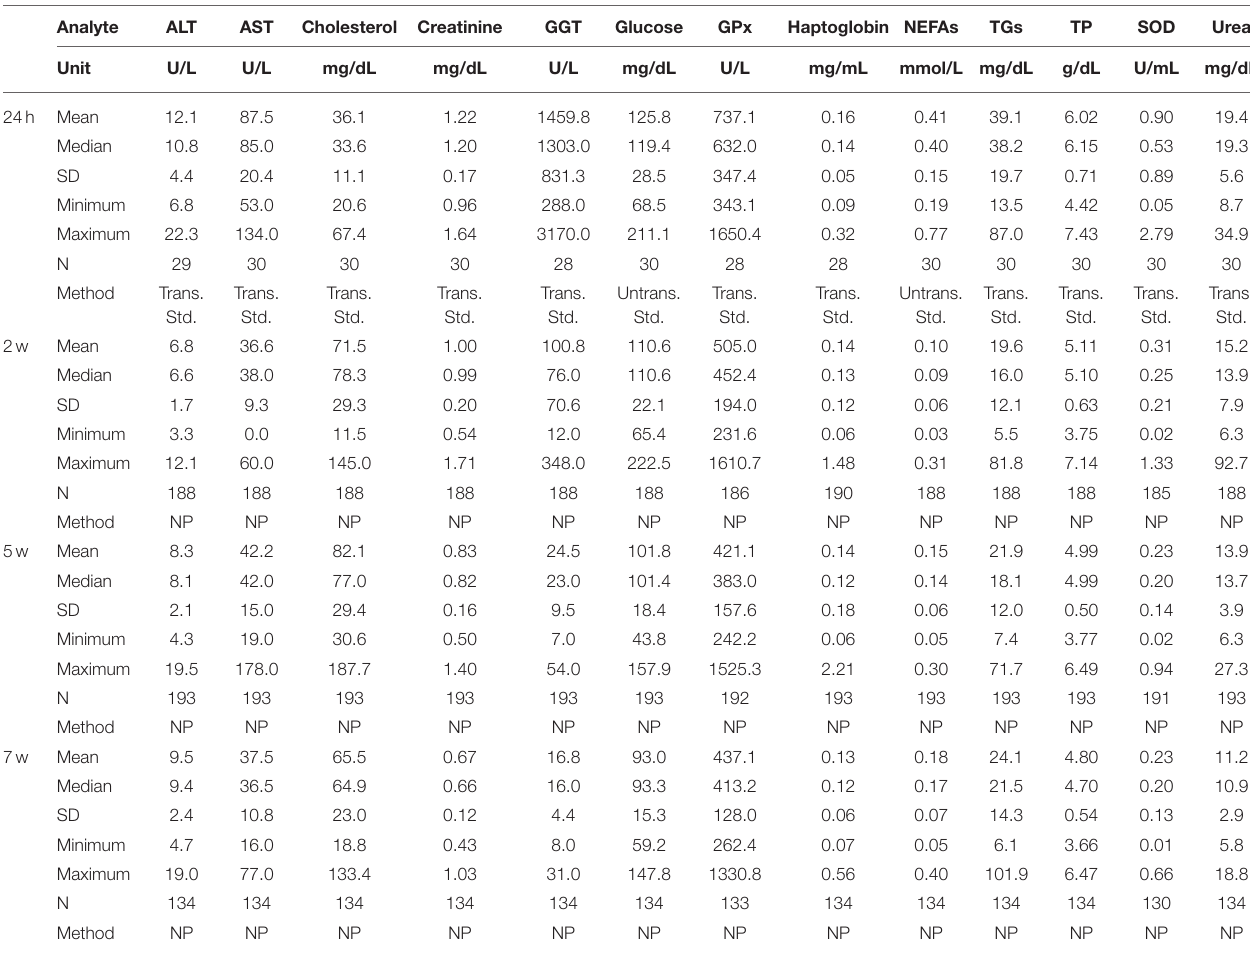
TABLE 1 | Summary of statistical values for clinical biochemistry analytes from calves of 24h (24h after colostrum taking), 2, 5, and 7 weeks of age. Analyte ALT AST Cholesterol Creatinine GGT Glucose GPx Haptoglobin NEFAs TGs TP SOD Urea